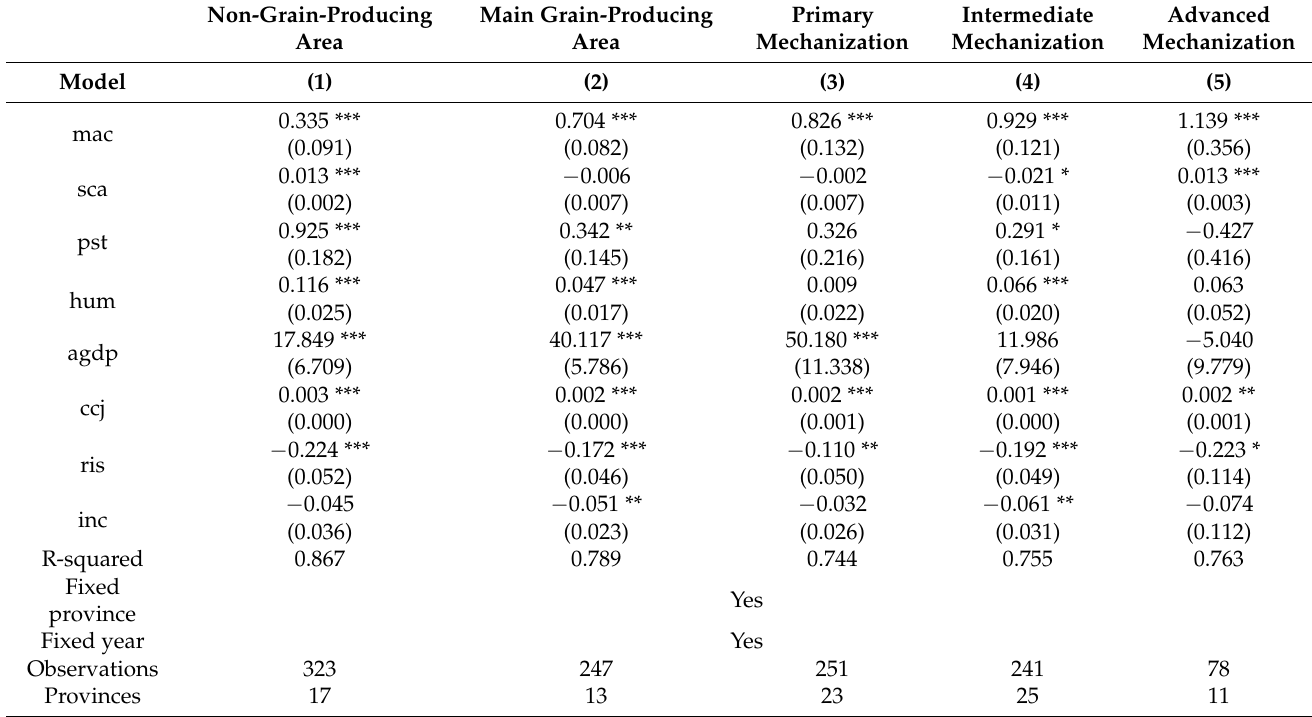
Table 5. Results of heterogeneity